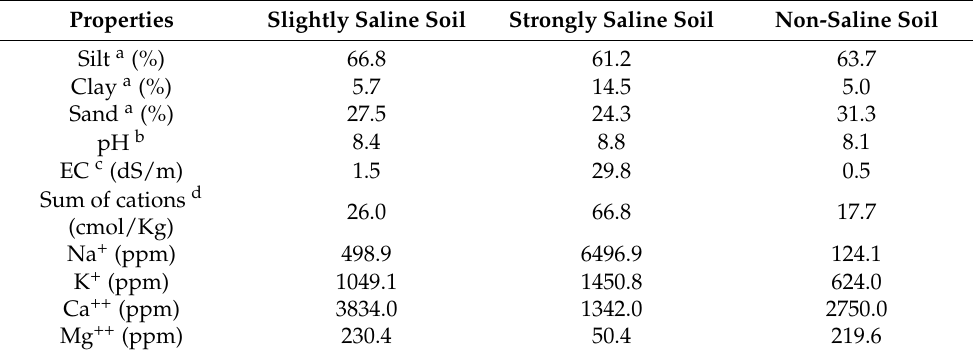
Table 1. Physicochemical characteristics of soil